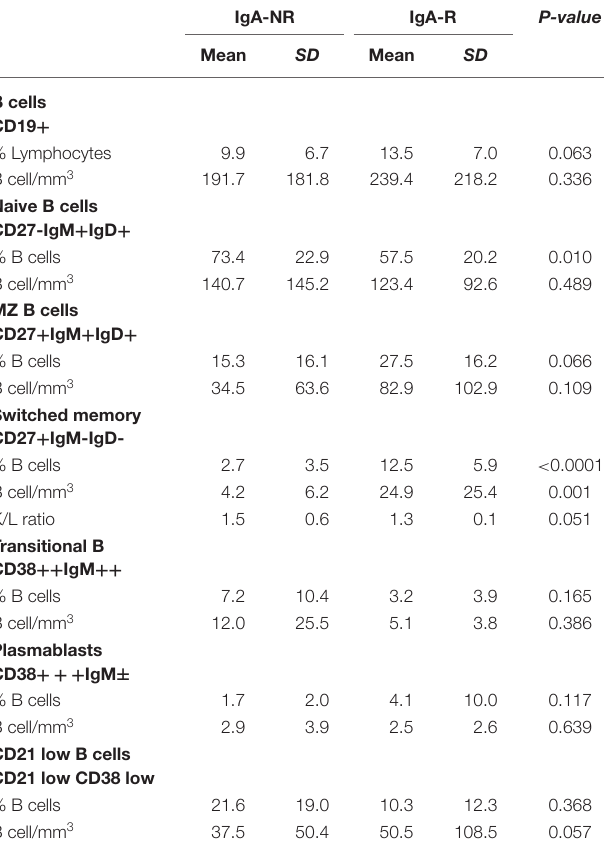
TABLE 3 | Frequencies and absolute count of T cells subsets and significance levels in patients grouped by post vaccination serum levels of Anti-PnPs IgA as IgA non-responders (NR) and IgA-responders (R). IgA-NR IgA-R P-value